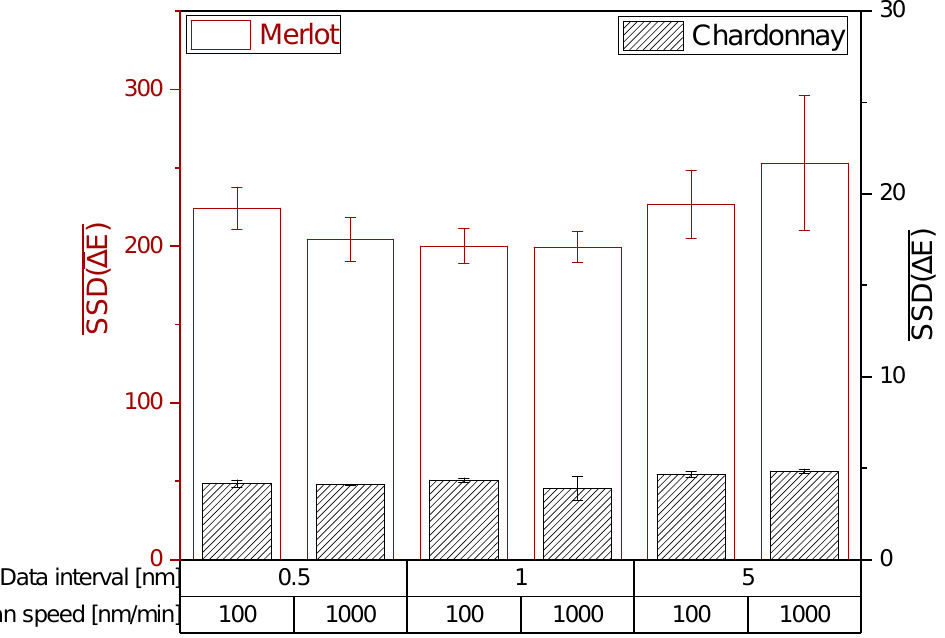
Figure 4. Influence of the photometer settings data interval and scan speed on the CIE L*a*b* coordinates on the JASCO V-730 double beam photometer. The mean sum of squared deviations are shown with error bars (SD; n = 3; α =